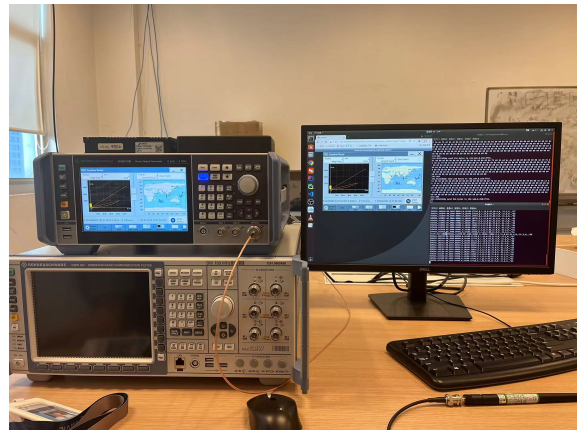
Figure 27. GNSS test hardware and test